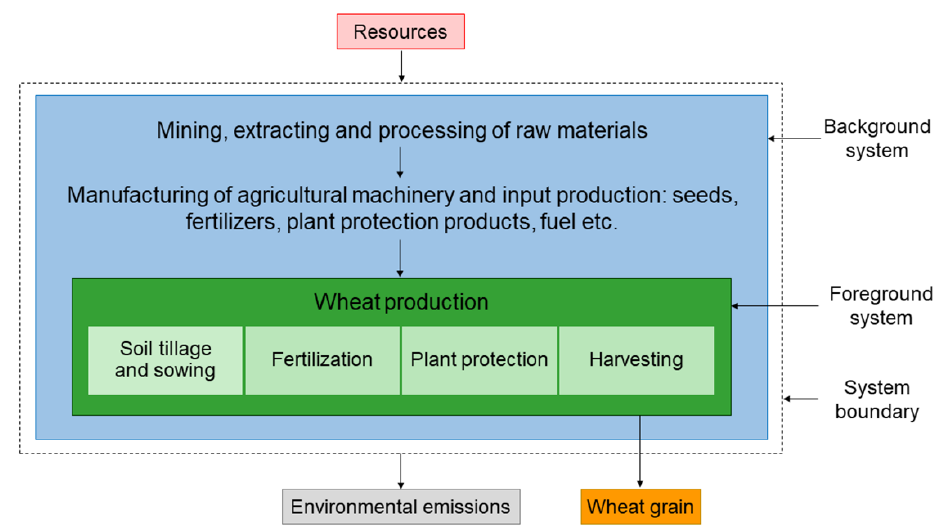
Figure 2. Boundary system for the life cycle assessment (LCA) of the winter wheat production.